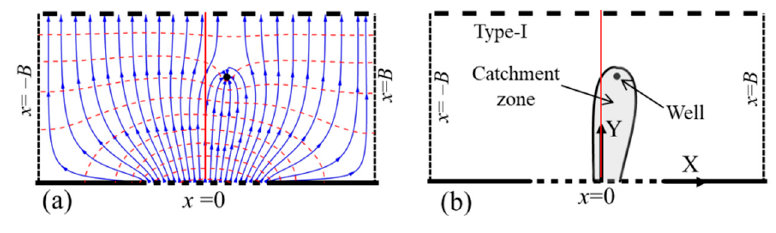
Figure 3. The flow net ( a ) and catchment zone ( b ) of type-I.